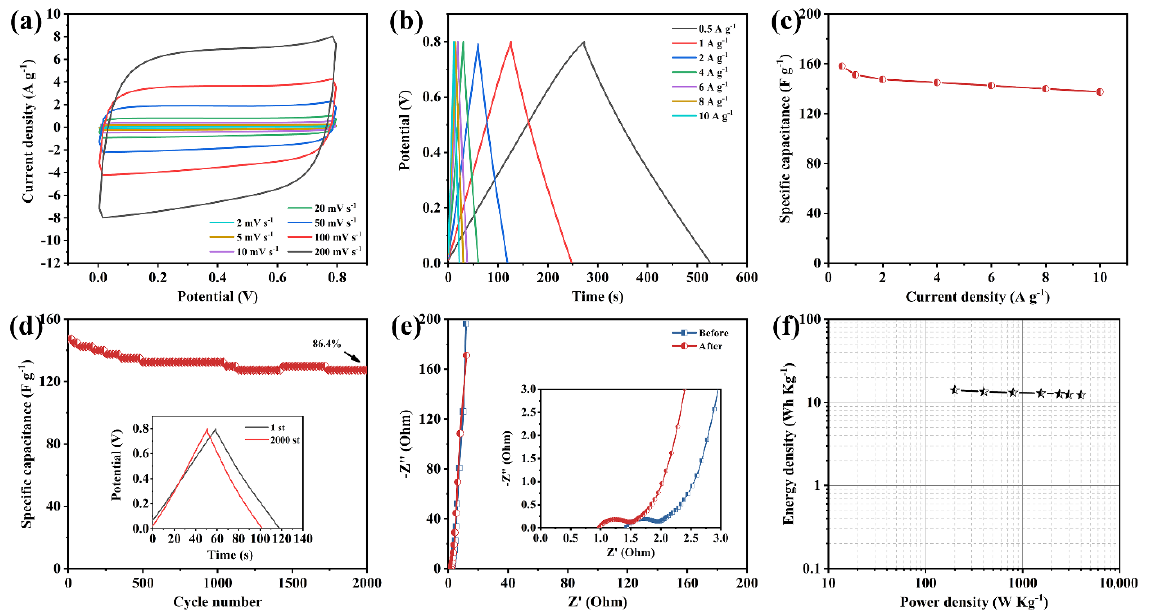
Figure 7. Electrochemical behaviors of the NHCS-30 based symmetric supercapacitor. ( a ) CV curves at different scan rates at voltages from 0 to 0.8 V; ( b ) GCD curves at different current densities; ( c ) Specific capacitance calculated by different current densities; ( d ) Cycling stability measured at 2 A·g −1 ; ( e ) Nyquist plots; ( f ) Energy density vs. power density.